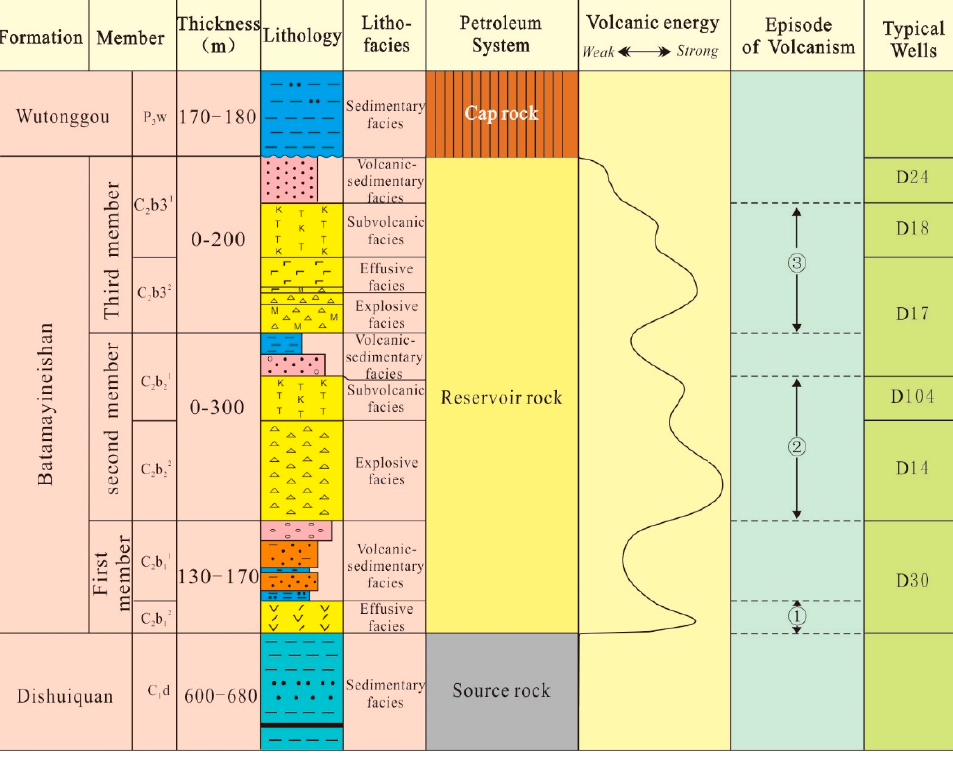
Figure 2. Simplified stratum column of Dixi Area in Kelameili Gas Field, Junggar Basin.